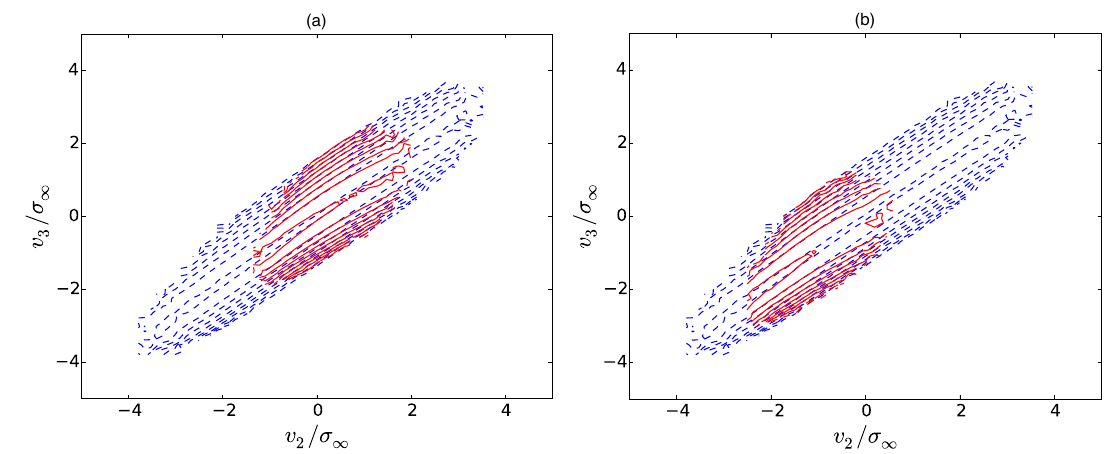
Figure 22. ( a ) examination of the Markov property (28) from DNS of the intermediate case for r = 1 λ and v 1 = 0 via a logarithmic contour plot; ( b ) same as in ( a ), but for v 1 = σ ∞